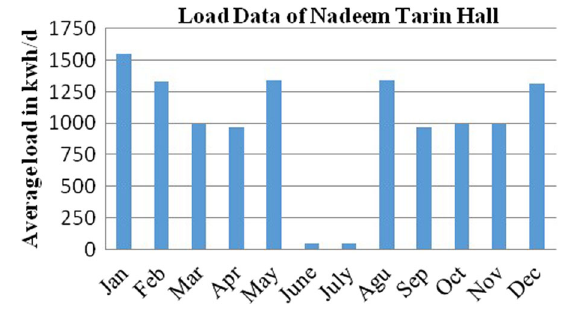
Fig. 2 Average load profile per